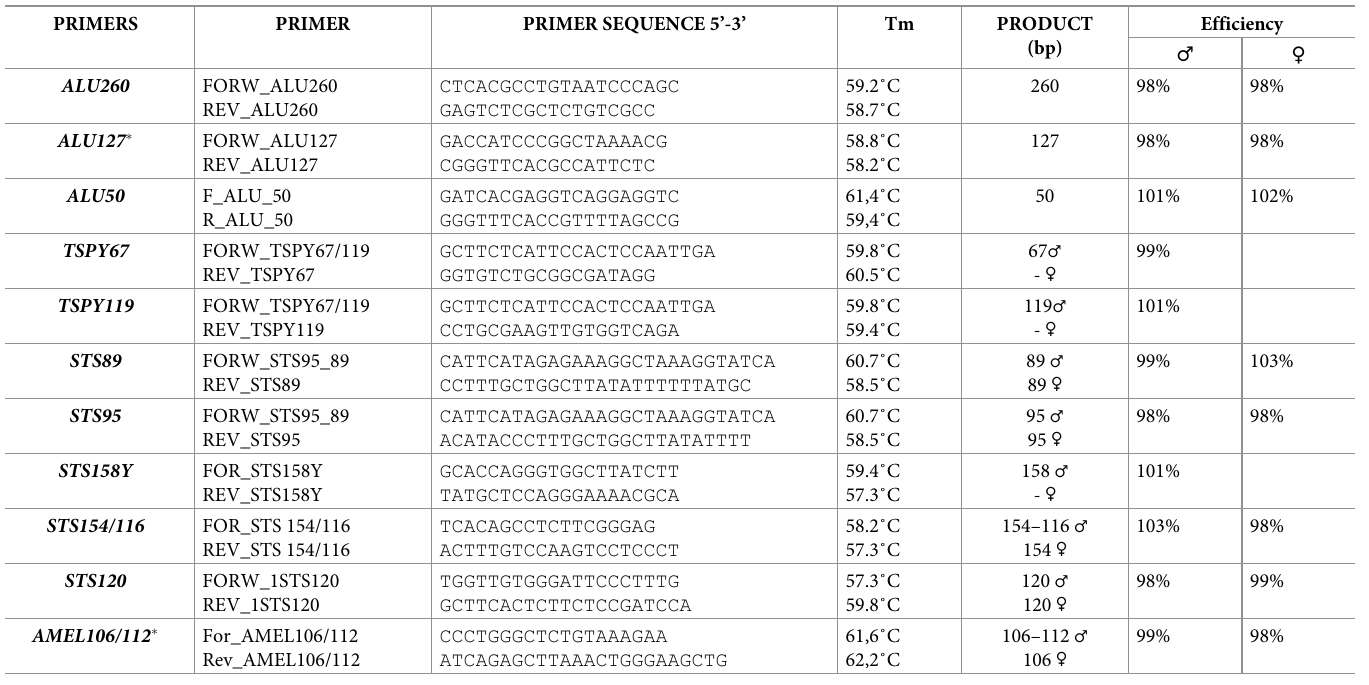
Table 2. List of primers